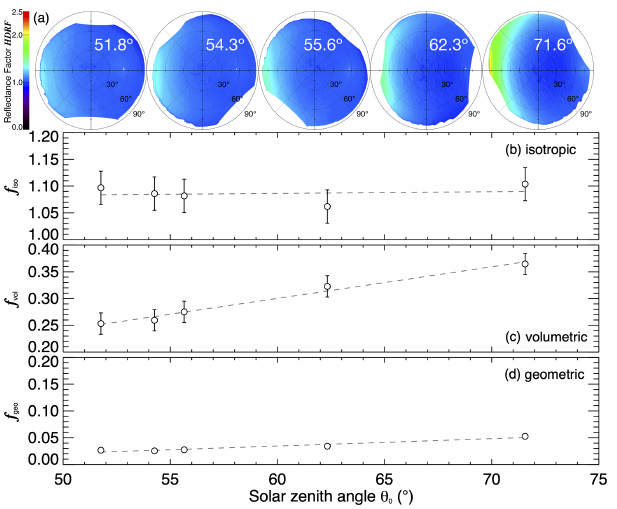
Figure 7. (a) Two examples of snow HDRF (490–585nm wave- length) at different times during an overflight over a sastrugi field on 2 January 2014 (morning flight). (b–d) Dependence of the re- trieved f k on the surface roughness. The dashed lines represent lin- ear regression fits of the parameters with respect to l rough . (b) The isotropic weight f iso . (c) The volumetric weight f vol . (d) The geo- metric weight f geo